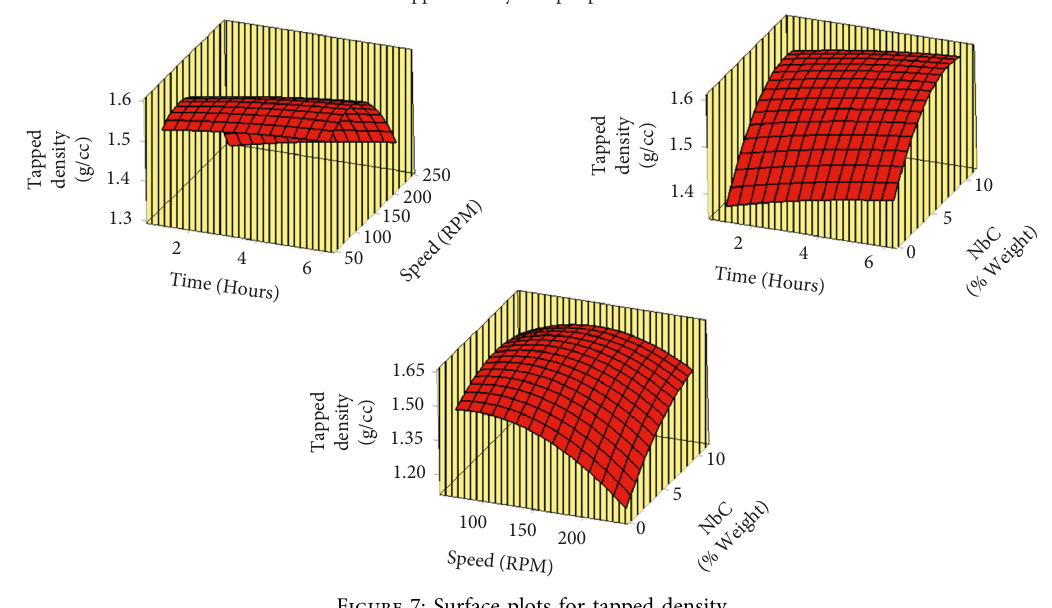
Figure 7: Surface plots for tapped density.